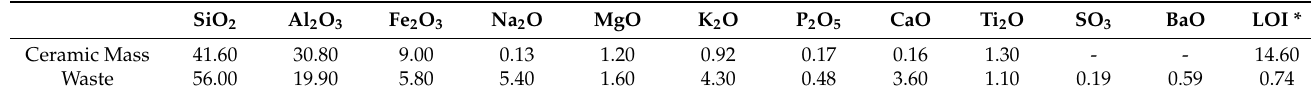
Table 2. Chemical composition of raw